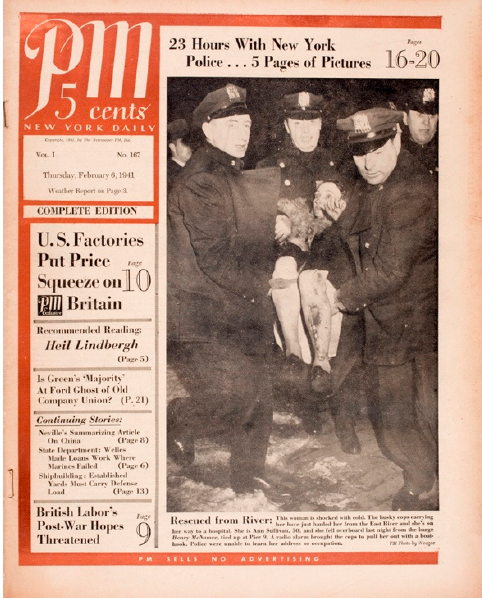
Figure 14. Weegee, “23 Hours With New York Police … 5 Pages of Pictures”, PM , 6 February 1941. Image courtesy of the International Center of Photography.